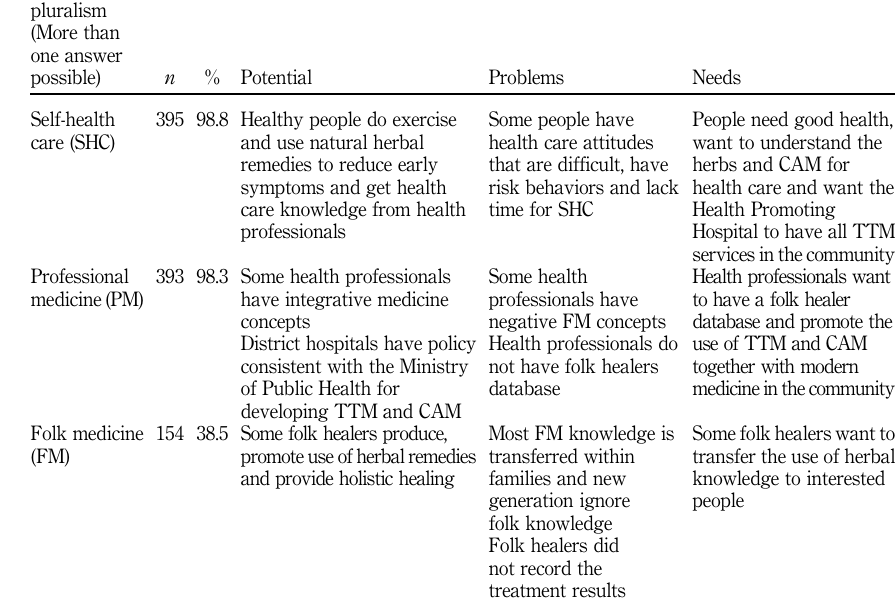
Table III. Phenomenon of medical pluralism in